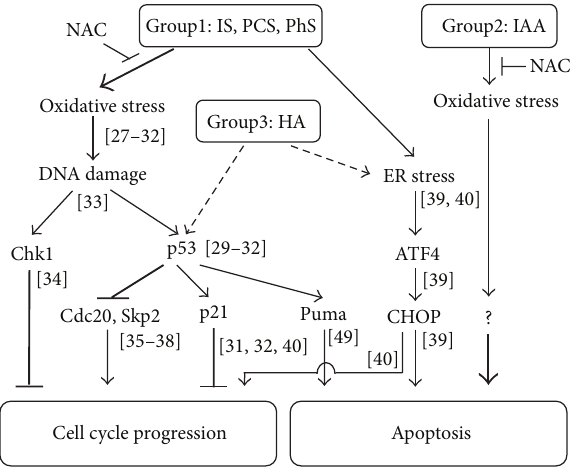
Figure 8: Schematic diagram of the effects of uremic solutes on porcine renal tubular cells. Group 1 exclusively induces cell cycle delay, which would be mediated by oxidative stress and ER stress. IS is reported to induce oxidative stress [27–32] and ER stress [40]. Oxidative stress can cause DNA damage, which is followed by Chk1 and p53 activation [33]. Activated Chk1 can arrest cell cycle progression [34]. Activation of p53 by IS is also reported [29–32]. Activated p53 can repress transcription of Cdc20 [38] and Skp2 [36, 37]. Because both Cdc20 and Skp2 have important roles in cell cycle progression [35], their repression might delay cell cycle. Another downstream target of p53, p21, which is also an important regulator of cell cycle, is also reported to be induced by IS [31, 32, 40]. Meanwhile, ER stress can induce ATF4 and CHOP expression, which is followed by apoptosis [39]. However, it is also reported that IS induced CHOP expression and CHOP mediatesinhibitionofproliferationinsteadofinductionofapoptosis in human renal tubular cells [40]. Thus, observed ATF4 and CHOP mRNA induction might be involved in cell cycle delay rather than apoptosis. Group 2 exclusively induces apoptosis, but its mechanism of action is largely unknown. Group 3 marginally induces both cell cycle delay and apoptosis, which might be partly mediated by p53 and ER stress. More detailed explanation is in Section 4. Cont, control; IS, indoxyl sulfate; PCS, p -cresyl sulfate; PhS, phenyl sulfate; HA, hippuric acid; IAA, indoleacetic acid; NAC, N-acetyl- L-cysteine. Number in brackets corresponds to the number of reference